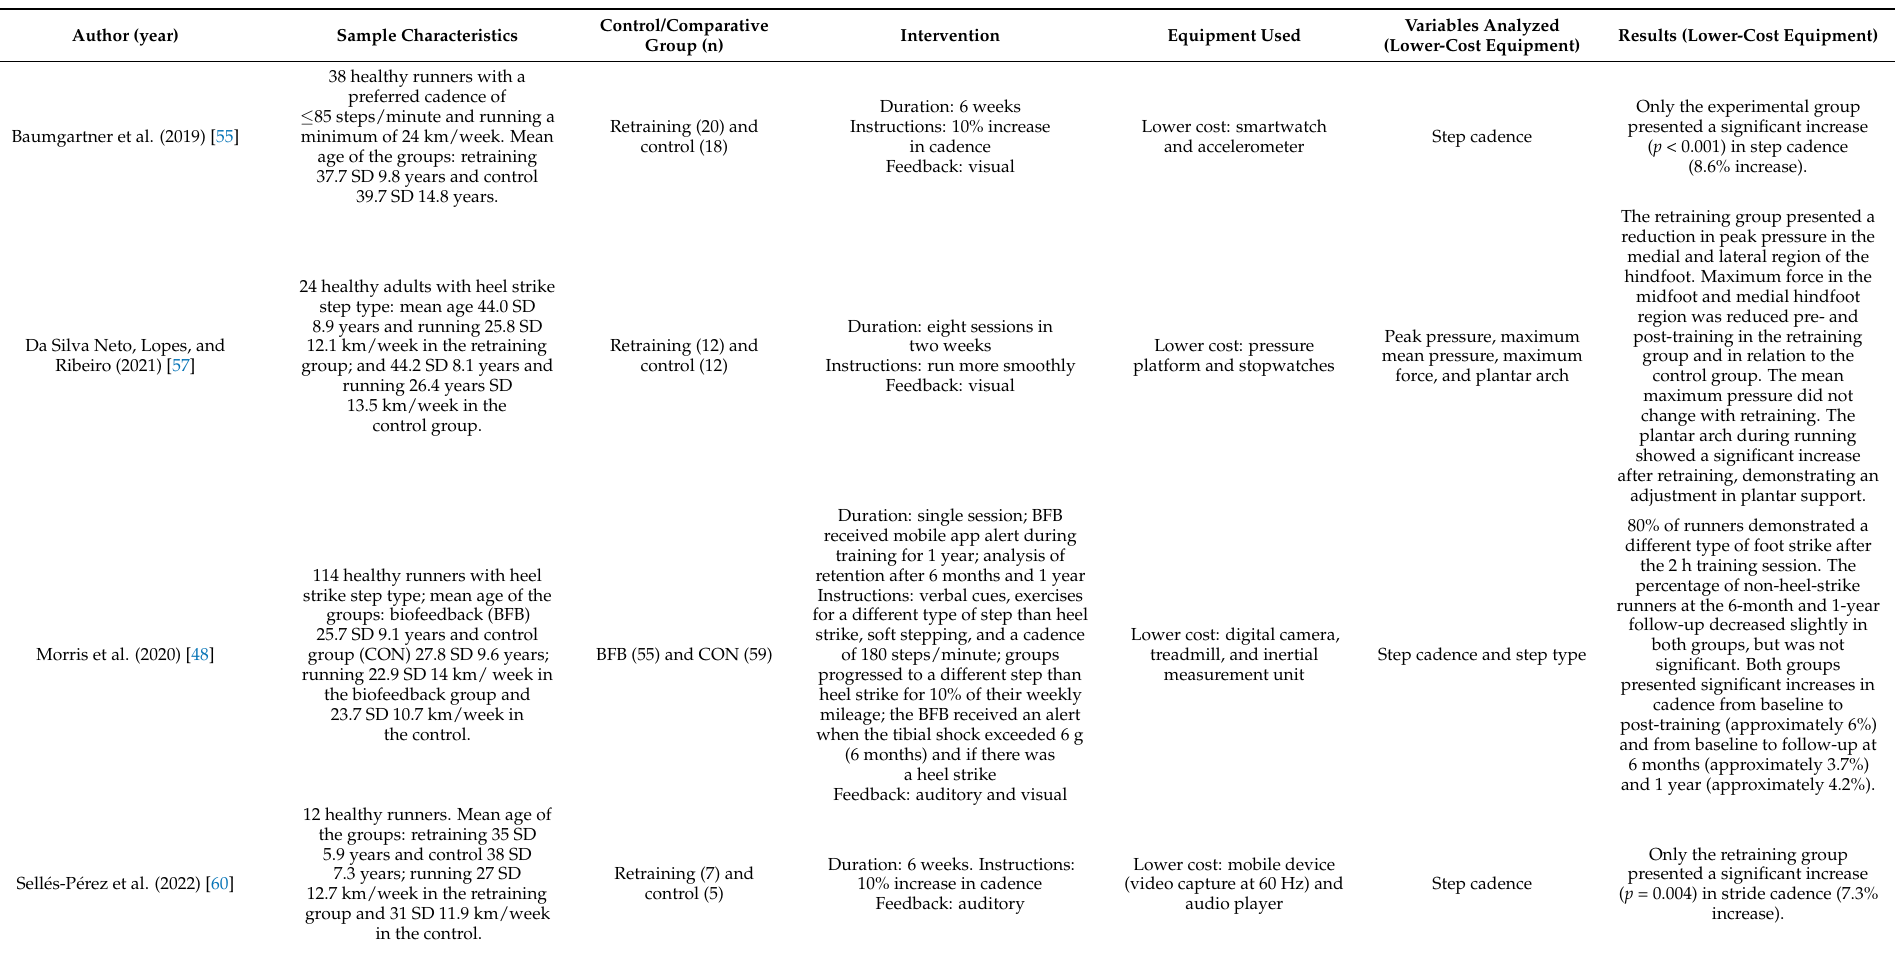
Table 2. Summary of experimental studies that analyzed spatiotemporal variables, kinetics, and foot kinematics as a retraining strategy using a control/ comparative